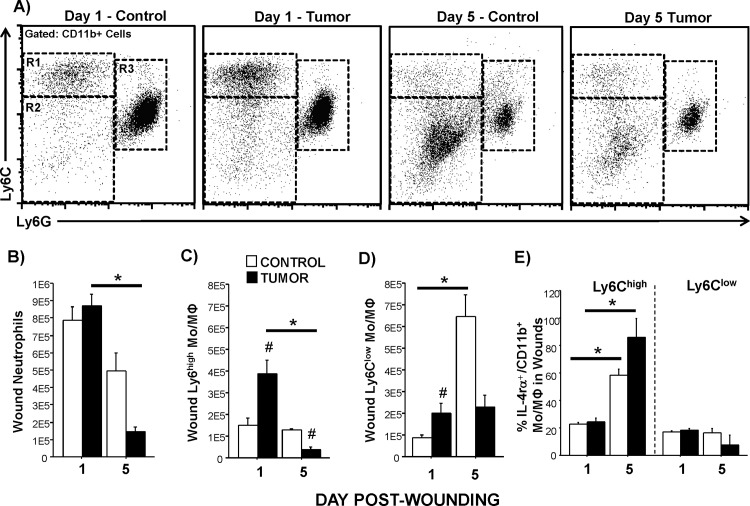
Tumors alter absolute myeloid cell numbers in wounds examined 1 or 5 days after wounding.Representative flow cytometry bivariate dot plots of Ly6C and Ly6G labeling of CD11b+ wound cells from mice (A) without tumors and with tumors 1 or 5 days post-wounding. Gates: R1 = Ly6Chigh Mo/MΦ, R2 = Ly6ClowMo/MΦ, and R3 = Neutrophils. Average (±SEM) (B) neutrophil (Cd11b/Ly6G+), (C) Ly6Chigh Mo/ MΦ, and (D) Ly6Clow Mo /MΦ isolated from wound tissues and quantified using flow cytometry. (E) Average (±SEM) percent of these Ly6Chigh or Ly6Clow Mo/ MΦ expressing IL-4Rα protein. n = 2-3/group; *p<0.05 within the same cancer treatment over time; #p<0.05 between treatments.